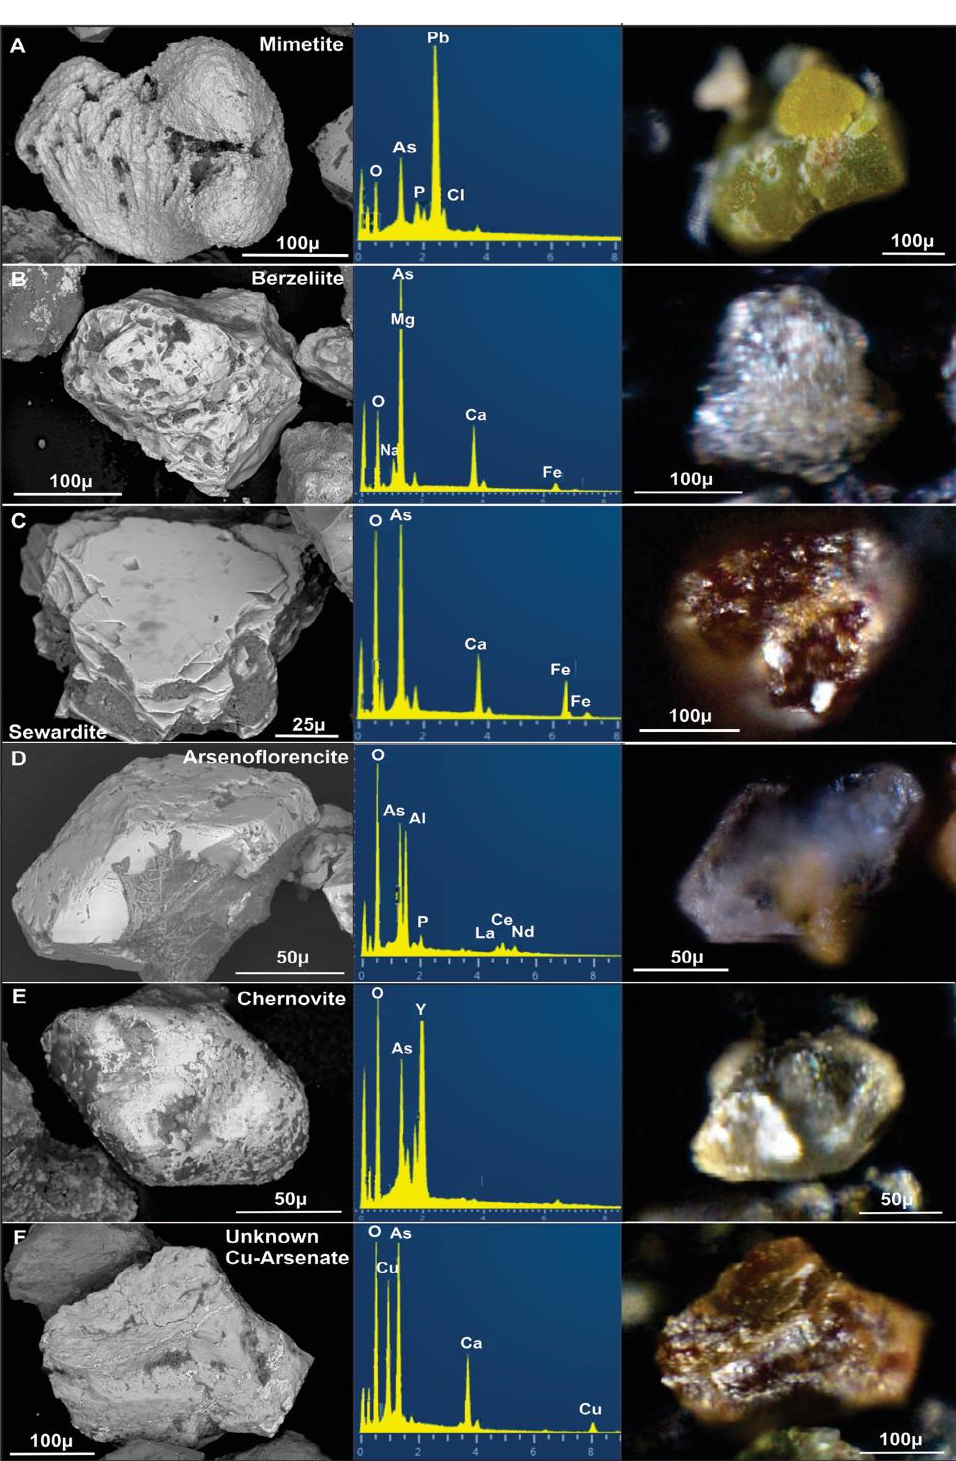
Figure 7. BSE images, EDS spectra, and photograph triplets of arsenates in the heavy mineral concentrate. ( A ) Mimetite; ( B ) Berzeliite; ( C ) Sewardite; ( D ) Arsenoflorencite; ( E ) Chernovite; ( F ) Unknown Cu-Ca arsenate.